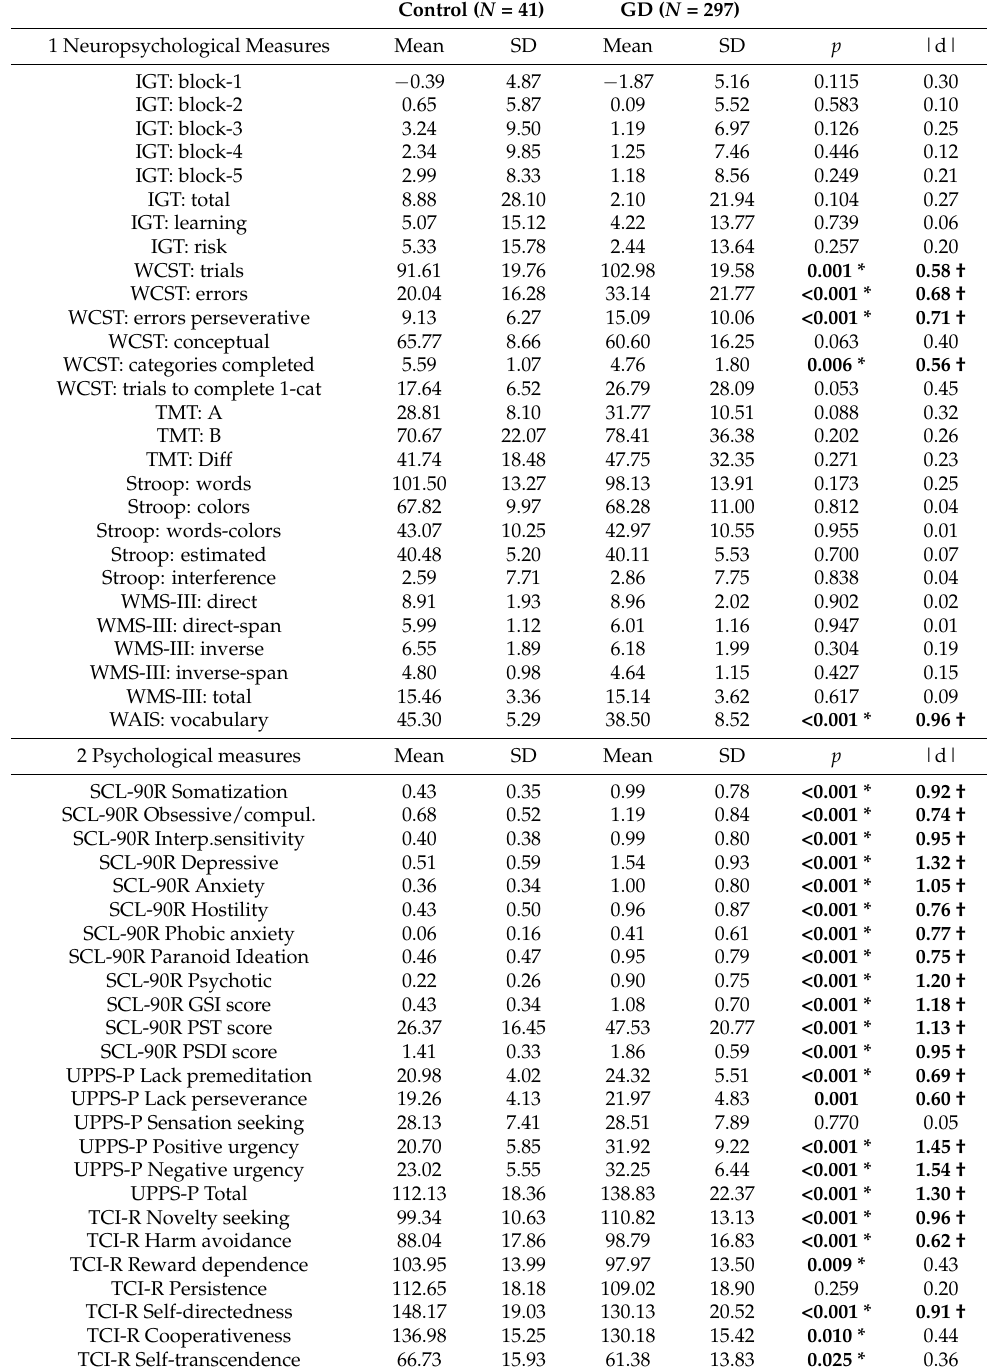
Table 2. Comparison of the clinical characteristics via